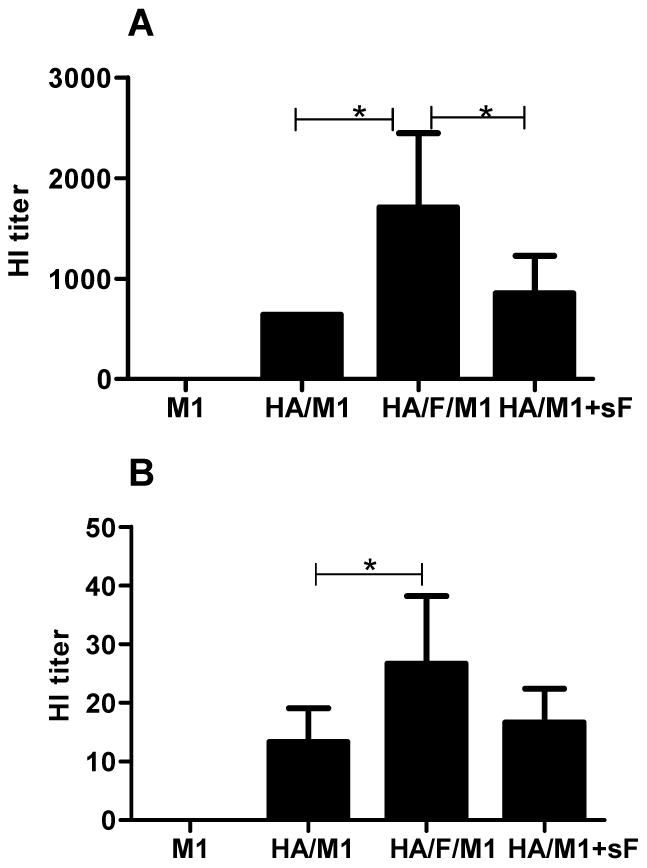
Hemagglutination inhibition (HI) titers against H1N1 PR8 or H3N2 Philippines virus.
A, HI titers to PR8 virus; B, HI titers to Philippines virus. HI titers of immune sera were determined as the capacity of sera to inhibit virus hemagglutination of chicken red blood cells. Representative data are the geometric mean ± S.D.